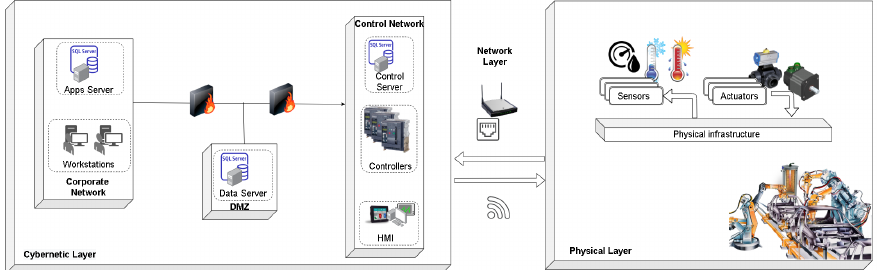
Figure 1. Architecture of a